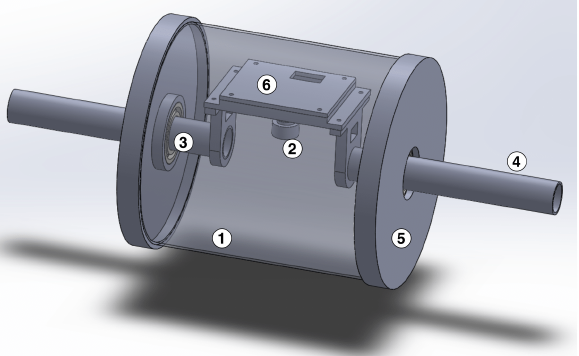
Figure 2. The design of the TouchRoller tactile sensor. (1) The transparent cylindrical tube; (2) the webcam; (3) ball bearings to make sure the camera point towards the region in contact with the object; (4) steel pipes; (5) sleeves to fix the cylindrical tubes and pipes; (6) the supporting plate to place the